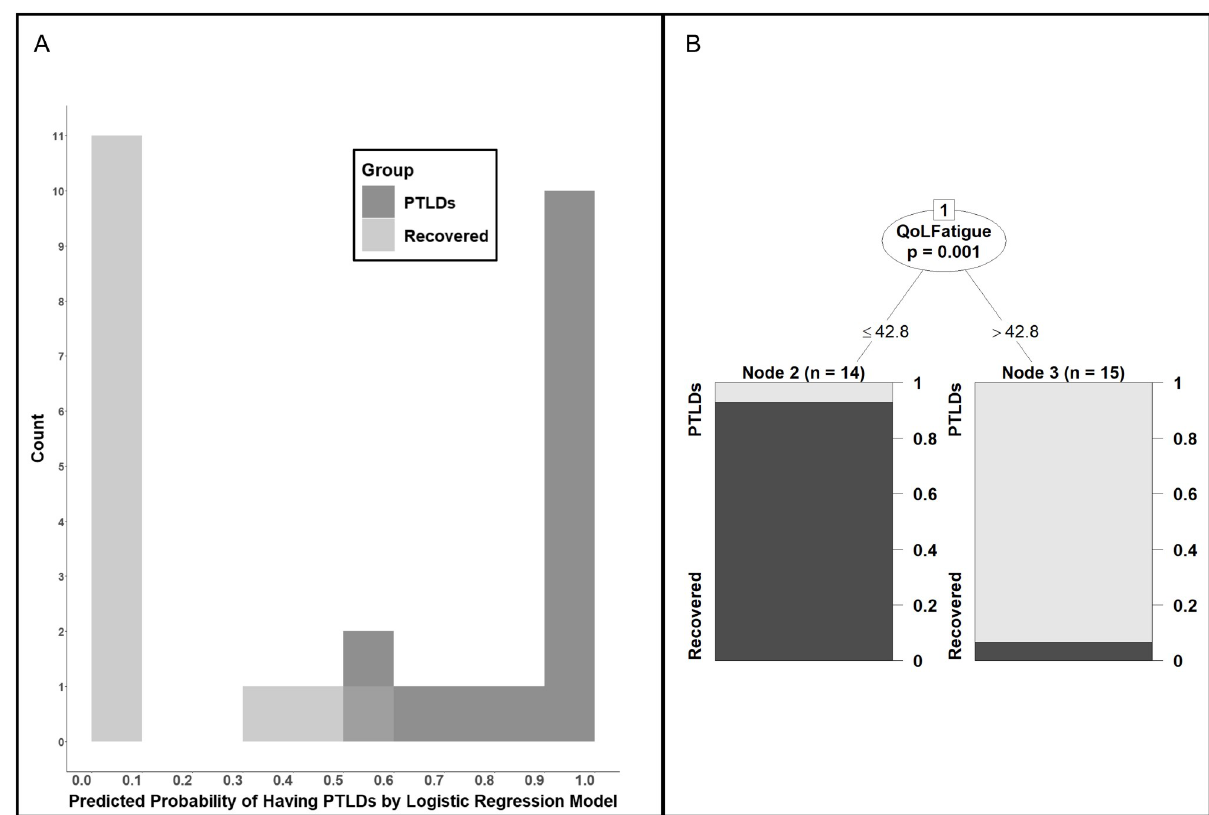
Fig 3. Post-treatment Lyme disease symptoms models. (A)The Logistic Regression model uses the Neuro-QoL Fatigue t-score ( Qol Fatigue ), the Physical Functioning score ( PF ) and the SF-36 Mental Health component score ( MCS ) to calculate a logistic predicted probability of post-treatment Lyme disease symptoms ( PTLDs ). The equation is: logit ð Pr ð Y ¼ PTLDs ÞÞ ¼ 49 : 66 þ 0 : 14 � ð QoLFatigue Þ (cid:0) 0 : 24 � ð PF Þ (cid:0) 0 : 76 � ð MCS Þ . (B) The Decision Tree model categorized QoL Fatigue t-scores � 42.8 into the recovered group and QoL Fatigue t-scores > 42.8 into the post-treatment Lyme disease symptoms (PTLDs) group.